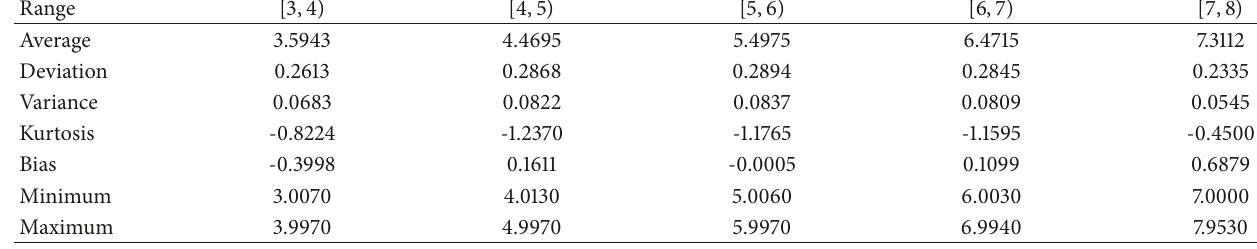
Table 1: Descriptive data for each of the five sets of 200 images that make up the proposed dataset.